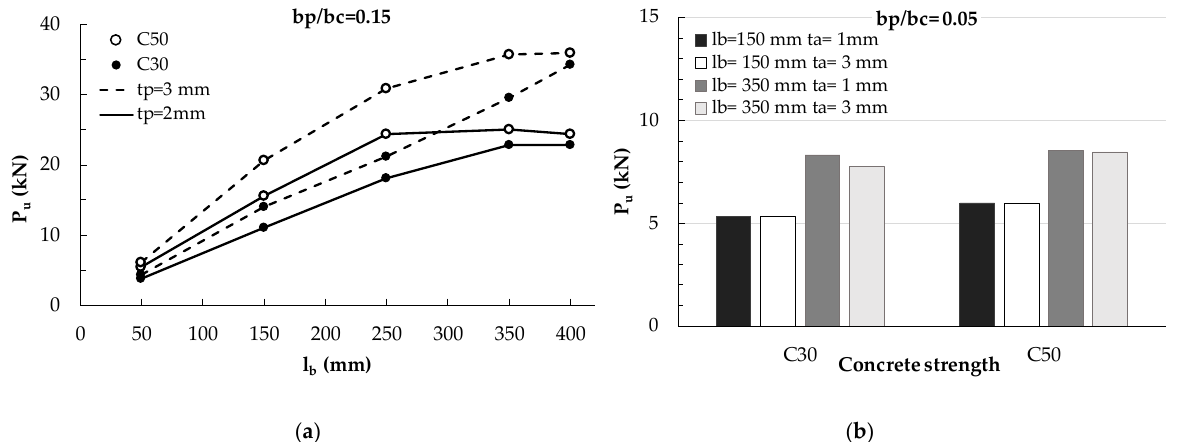
Figure 11. ( a ) Maximum debonding load vs. bonded length for different concrete strength and thickness of steel plate; ( b ) Maximum debonding load for t p = 2 mm by varying bonded length (150 mm and 350 mm), concrete strength (30 and 50 MPa), and adhesive thickness (1 mm and 3 mm).